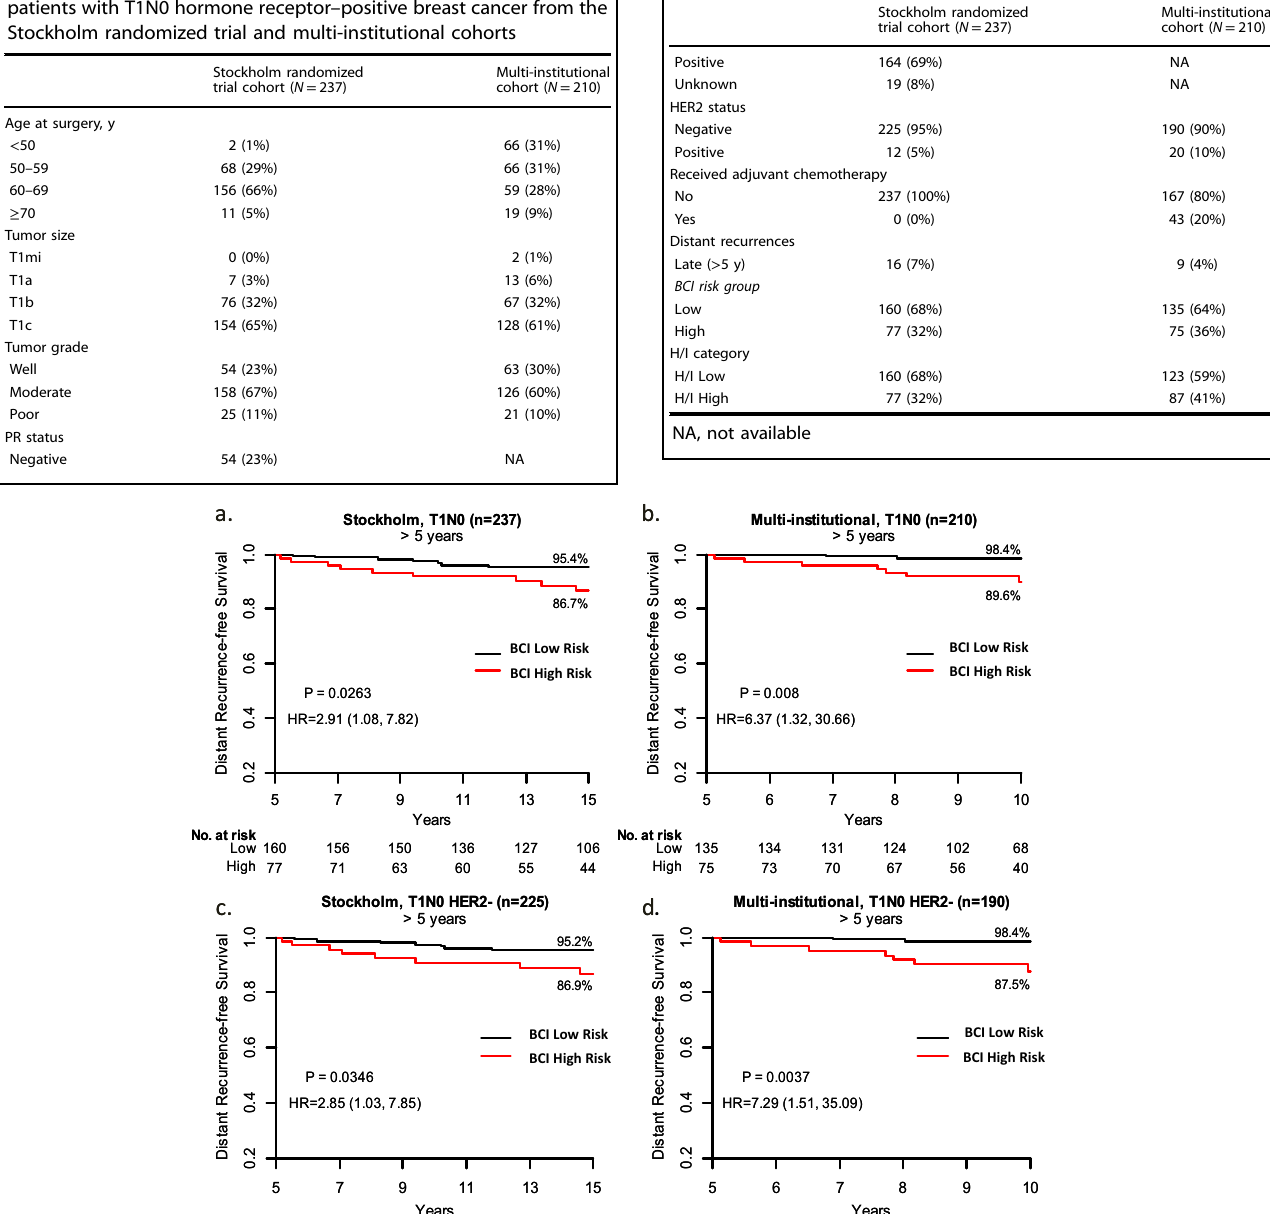
Multi-institutional cohort ( N =